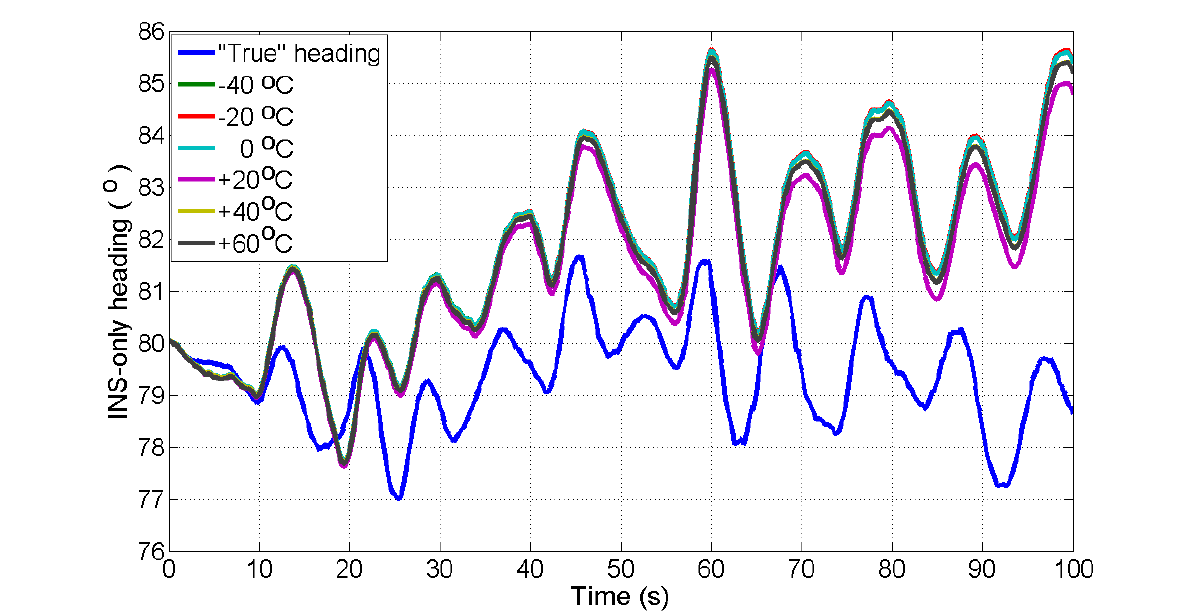
Figure 12. INS-only heading solution from kinematic test data collected at +17 °C during GPS outage#5 with AR-based GM model developed at different temperature points.